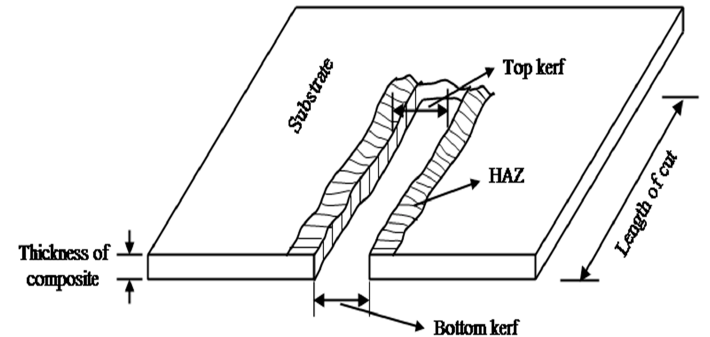
Figure 3. Kerf taper and heat affected zone measurements.